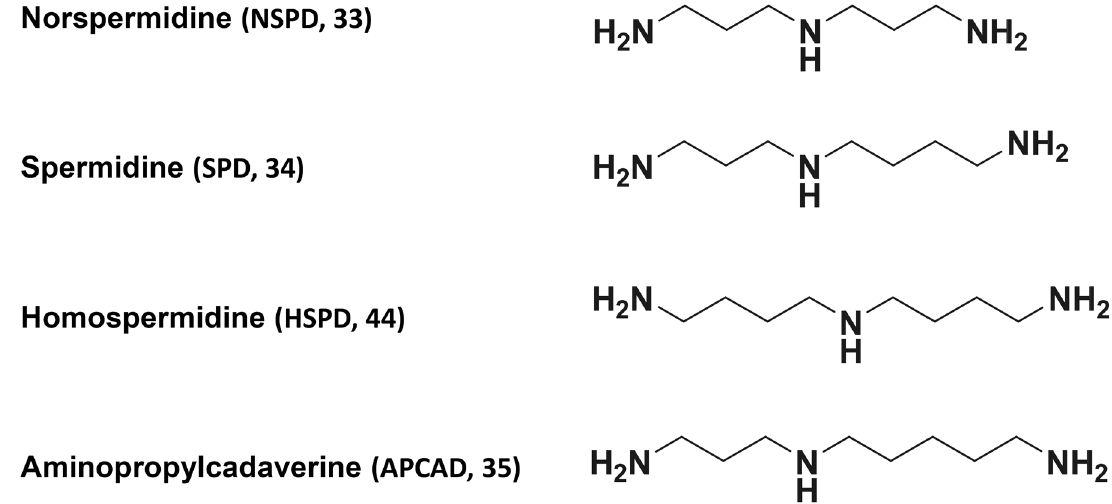
Fig 1. Structure of